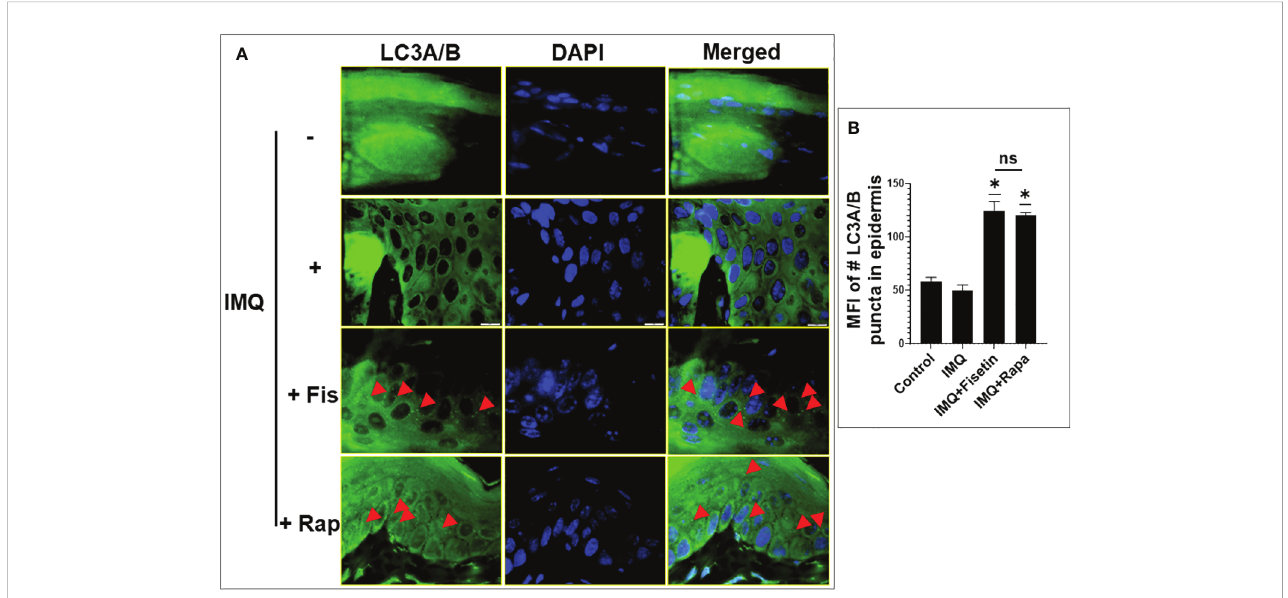
FIGURE 8 Fisetin induces the expression of autophagy marker LC3A/B in IMQ-induced skin lesion in mice. (A) LC3A/B (green) immuno fl uorescence staining and DAPI (blue) staining (for nucleus) in the skin tissue sections of vehicle-, IMQ-, fi setin+IMQ- and rapamycin+IMQ-treated mice. Red arrow heads in the fi setin+IMQ or rapamycin+IMQ treatment indicates green punctate staining of LC3A/B, which is absent in the control or IMQ treatment. Scale bar = 10 µm. (B) Quanti fi cation of fl uorescent intensity of LC3A/B-positive puntata per 60x fi eld view. Shown in bar graph are mean ± SD, and paired t test was used to compare values between different treatments, number of mice per group n=6. *P <0.05 and ns is non-signi fi